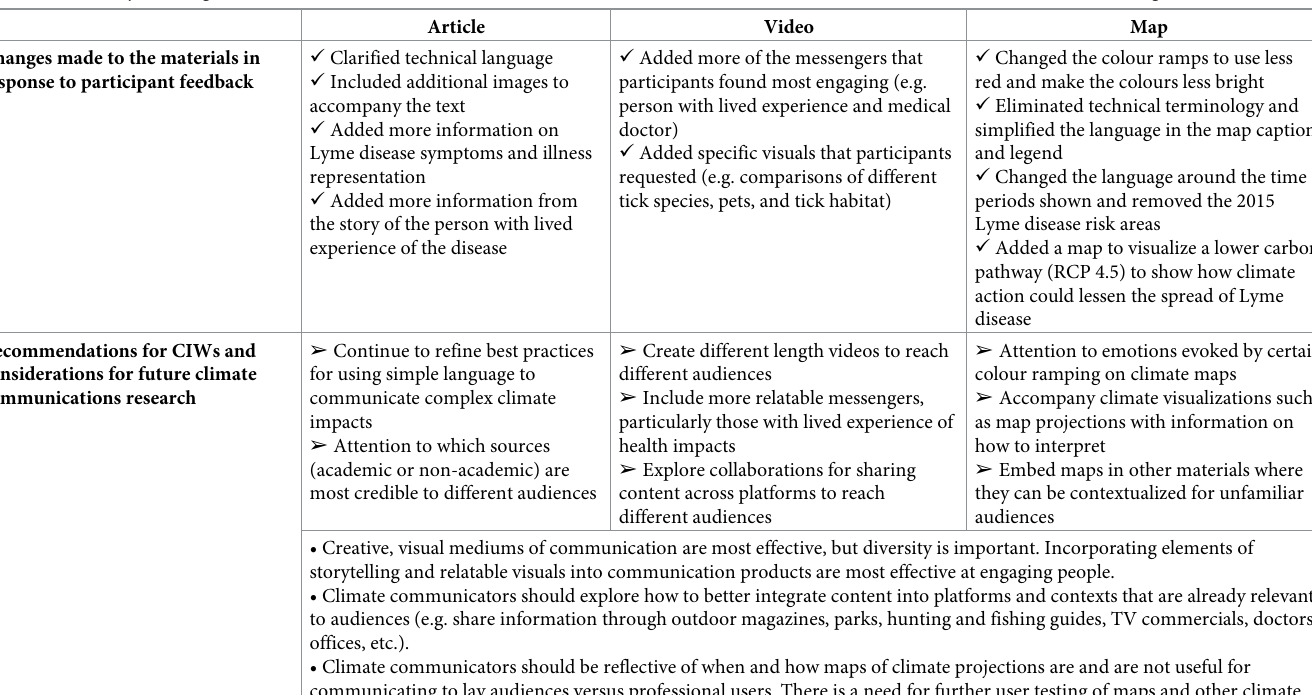
Table 3. Summary of changes made to the materials and recommendations for future online climate communications based on current